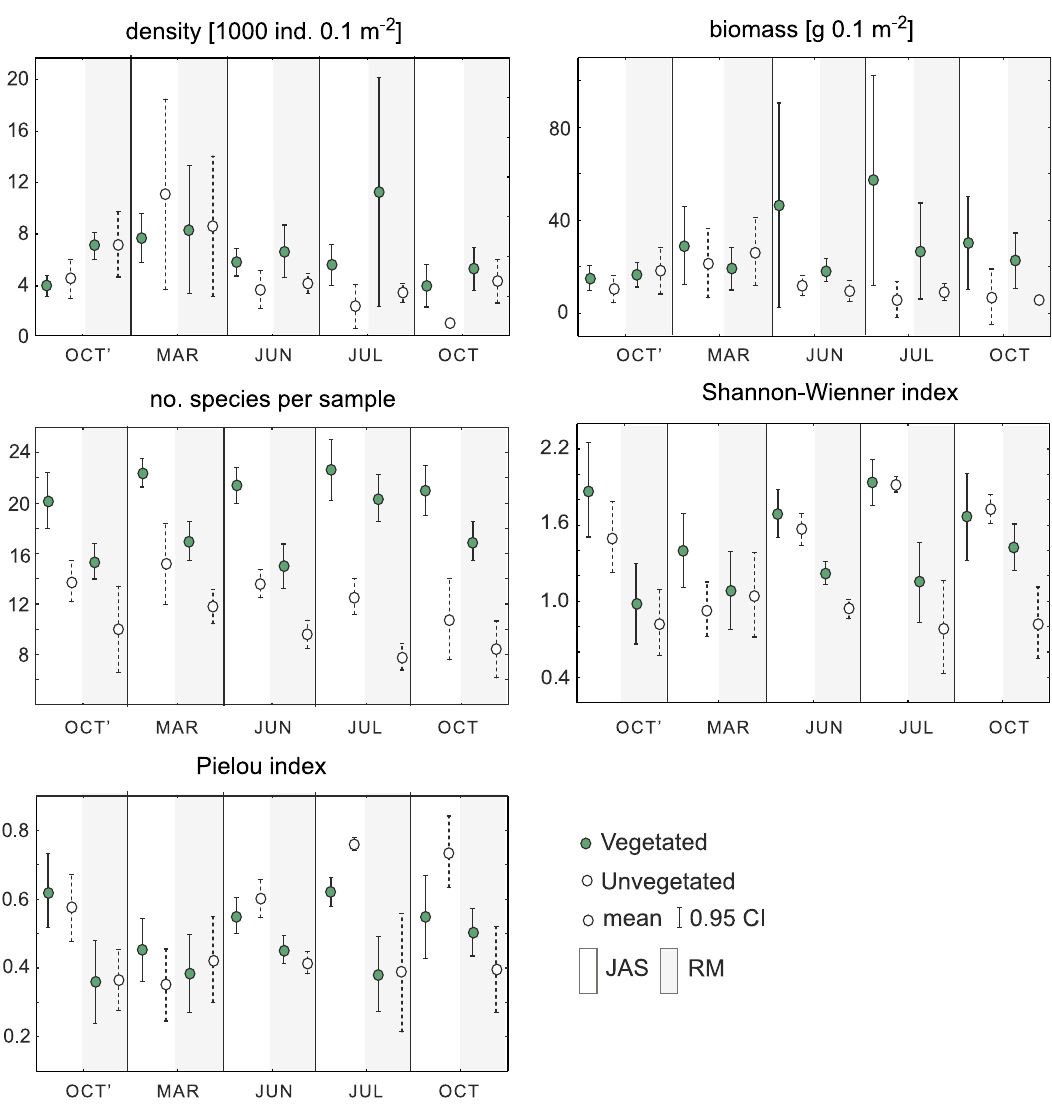
Figure 3. Seasonal variability in macrozoobenthic community characteristics. Density [1000 ind. 0.1 m 2 2 ], biomass [g 0.1 m 2 2 ], species richness (number of species per sample), diversity (Shannon-Wiener index), and evenness (Pielou index) recorded in 5 months (OCT’- October 2010, MAR - March 2011, JUN - June 2011, JUL - July 2011, OCT - October 2011) at two stations (JAS - white background, RM - gray background) and two bottom types (vegetated, unvegetated). Mean and 0.95 CI values are presented. bottom type and station had a much stronger effect on species richness than did month (Table 1). Throughout the year S was higher at the JAS site (mean 17.4 6 4.6 SD) than at the RM site (mean 13.2 6 4.3, Figure 3). S was also higher in vegetated bottoms than on bare sand for all combinations of months and sampling sites. The effect of vegetation on S was significant in all months, but the ratio of the mean recorded in vegetated sediments to that on bare sand increased from 1.5 in OCT’ and MAR and 1.6 in JUN to 1.9 in OCT and 2.1 in JUL (Figure 4). Evenness ( J ) was higher in samples collected at the JAS site than at RM, but this difference was not consistent throughout the sampling period as was indicated by the significant effects of months and significant MtxSt interaction (Table 1). The lowest and highest mean values of J were recorded on bare sand at the JAS site, with the lowest in March (0.351 6 0.084 SD) and the highest in July (0.760 6 0.015,